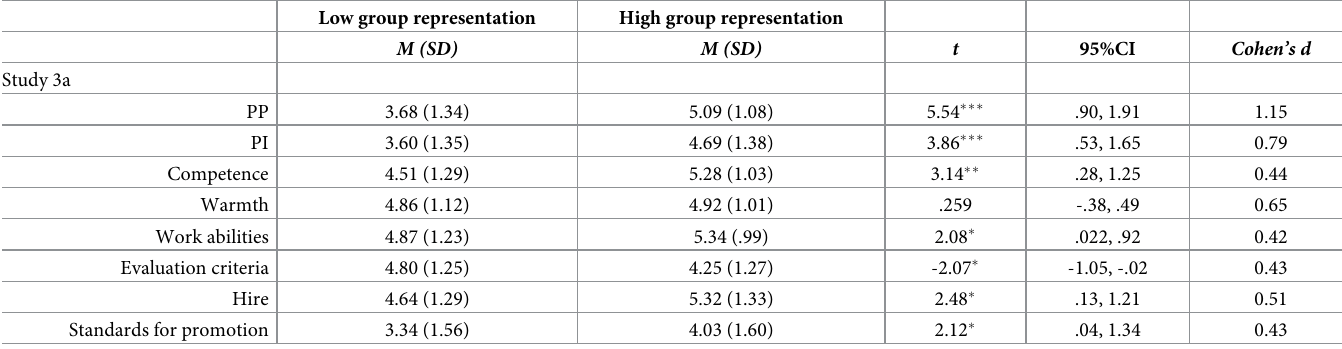
Table 6. Tests for the effect of group representation on place-prototypicality, place-identification, and intergroup outcome variables (Study